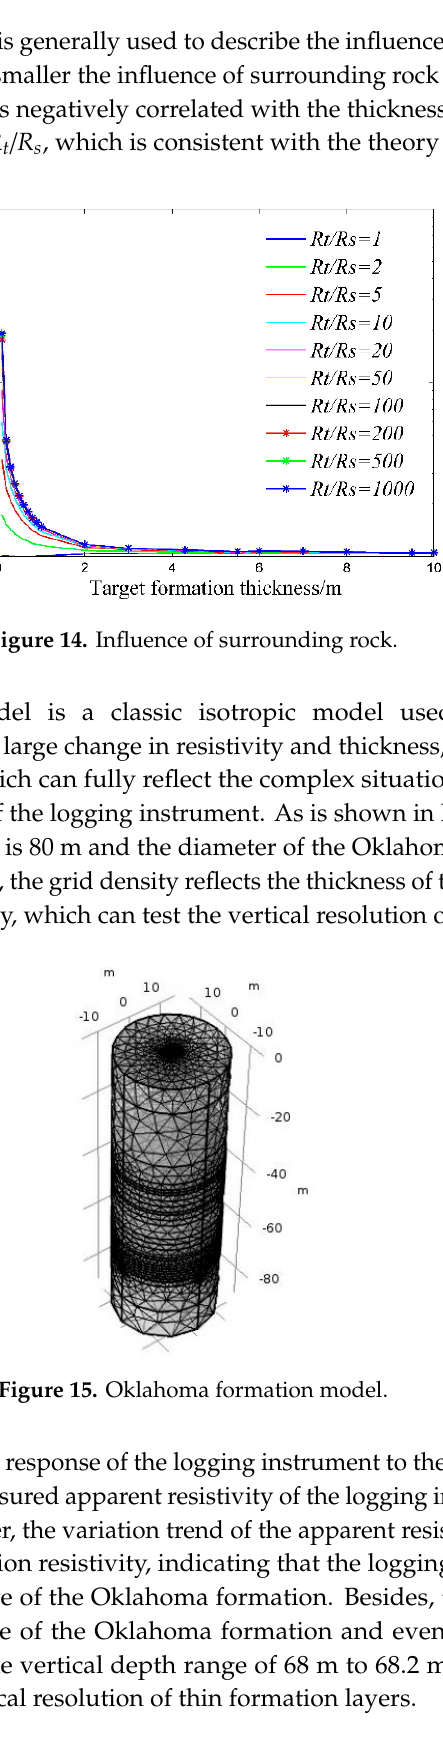
Figure 15. Oklahoma formation model.